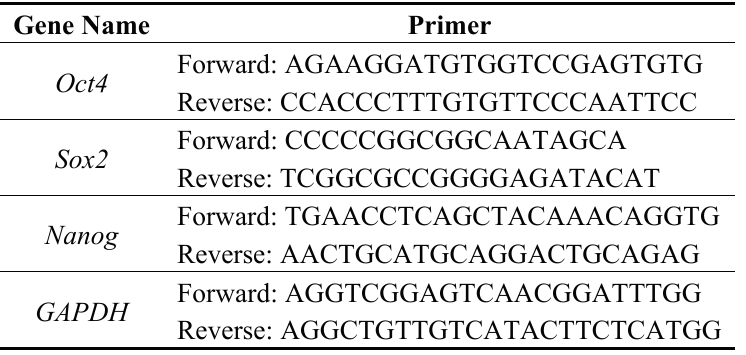
Table 1. Primers used for real-time polymerase chain